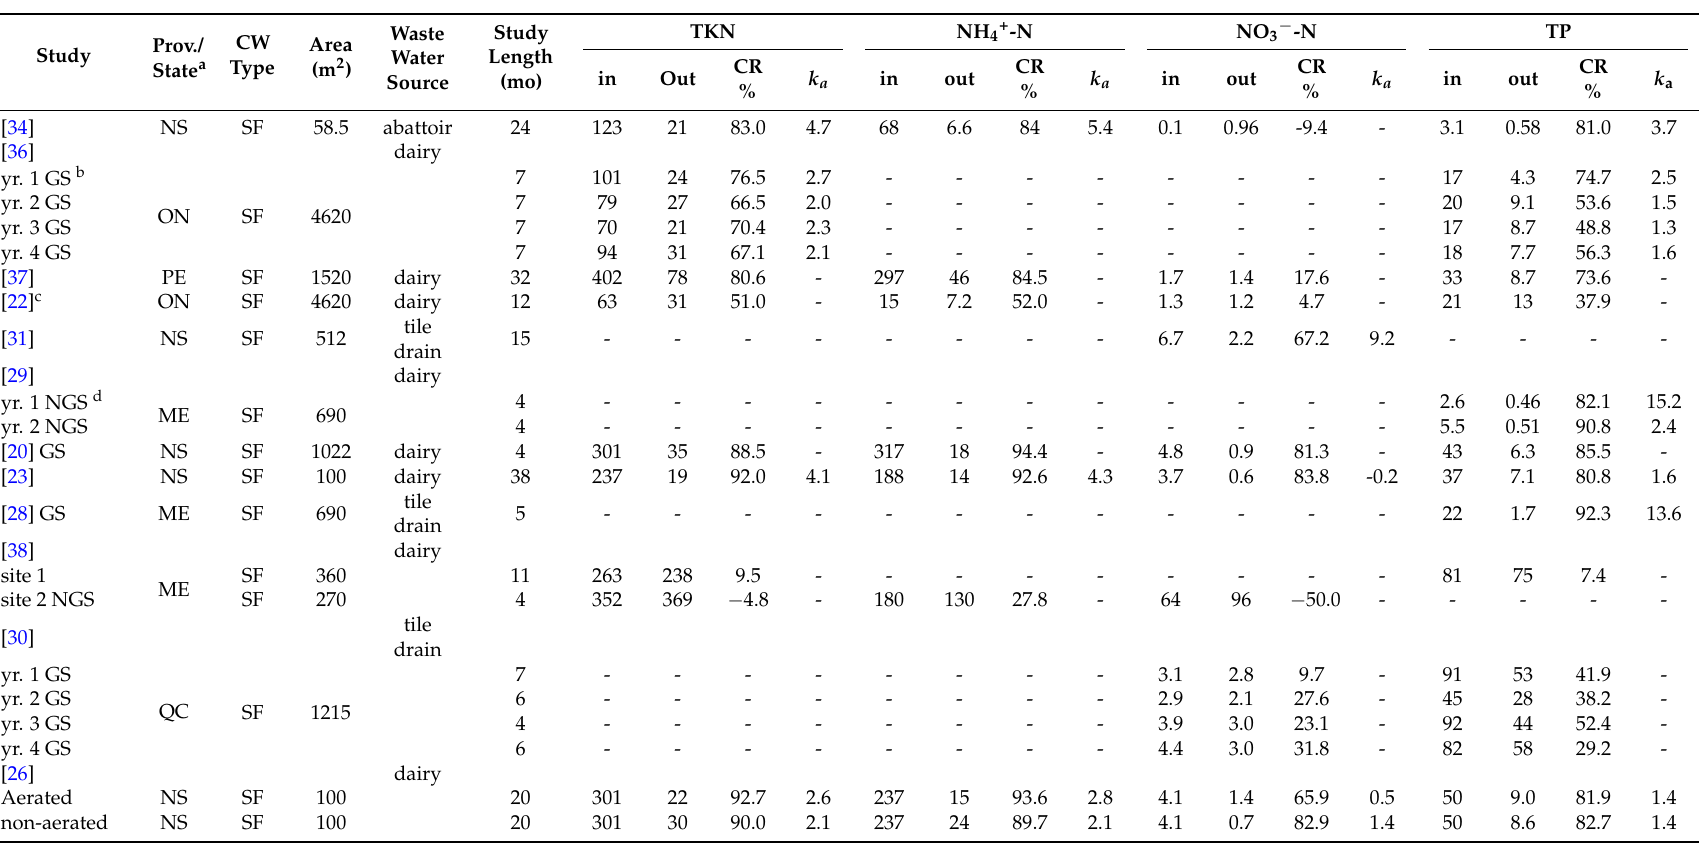
Table 2. Mean influent and effluent concentrations (mg L ´ 1 ), concentration reductions (CR, %), and areal adjusted rate constants (k a , m ¨ y ´ 1 ) for total